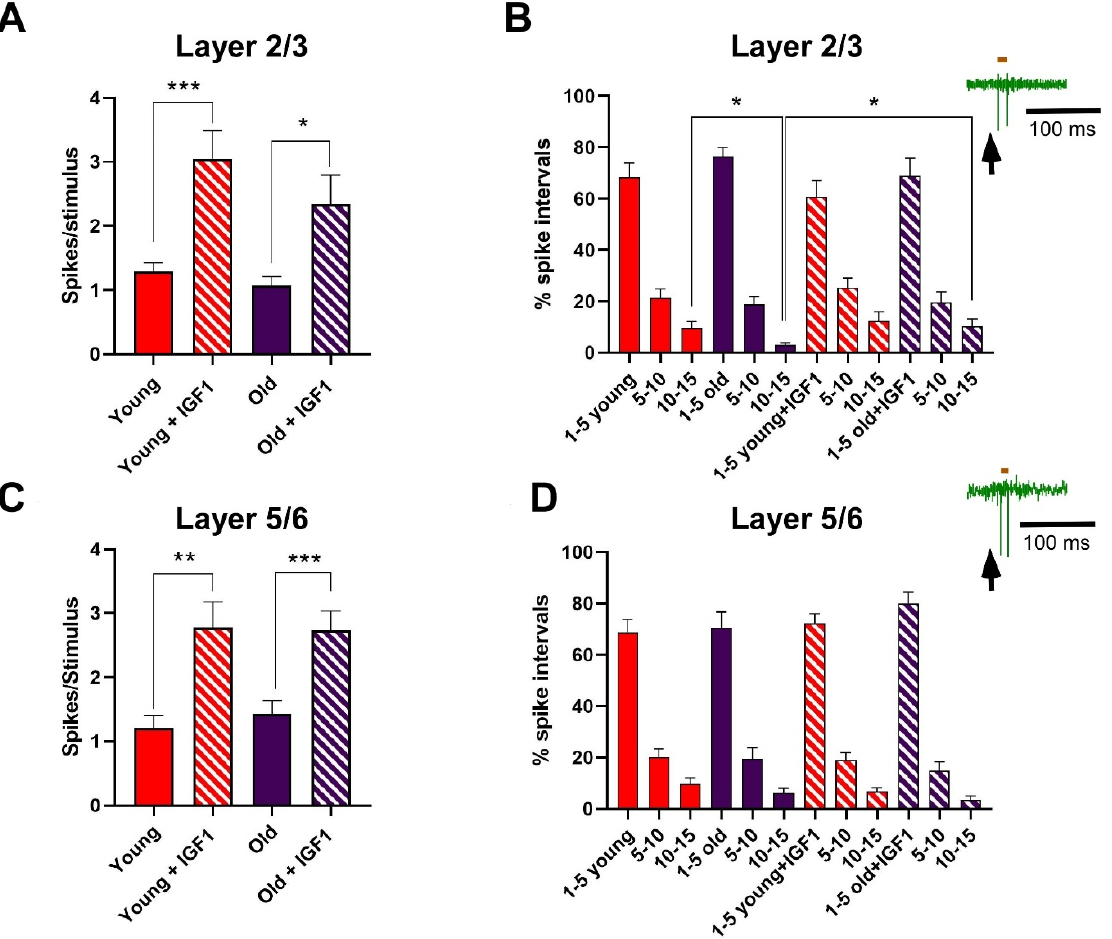
Figure 1. Responses to whisker stimulation increased in the presence of IGF-I in young and old animals in S1 cortex. ( A ) Plot shows the mean number of spikes/stimulus in layer 2/3 neurons in young animals (red) and old (purple) animals in comparison with values obtained 15 min after the application of IGF-I (10 nM; 0.2 μ L). Whisker responses were similar in young and old animals; responses increased after IGF-I application in both animal groups. ( B ) The mean percentage of spike intervals in three time ranges (1–5; 5–10 and 10–15 ms) during whisker responses in young and old animals is shown in layer 2/3 neurons. The percentage of spike intervals is shown in control condi- tion and 15 min after application of IGF-I. Data show a significant reduction in the percentage of long intervals (10–15 ms) in neurons recorded from old animals with respect to young ones. The percentage of long intervals in old animals was recovered when whisker responses were recorded after IGF-I application. Inset in B shows a representative response to whisker stimulation in a layer 2/3 neuron; the brown bar on the recording shows a spike interval used to calculate the interval histogram. ( C , D ) The mean responses in layer 5/6 neurons as shown in A and B. Note that whisker responses were similar in young and old animals in control conditions and increased after IGF-I application. The percentage of spike intervals did not show significant differences neither between different animal groups nor after the application of IGF-I. All values are expressed as mean ± SEM; Student’s t -test; * p < 0.05; ** p < 0.01, and *** p < 0.001 for comparisons. It is known that IGF-I increases neuronal response and its neuronal response is re- duced in aging (see Introduction). Thus, we studied its effect on whisker responses in young and old mice. In agreement with previous findings, local application of IGF-I in the S1 cortex (10 nM; 0.2 μ L) increased whisker responses 128% in layer 2/3 neurons of young animals (3.1 ± .0.4 spikes/stimulus, 15 min after IGF-I cortical application; n = 13; p = 0.002 with respect to basal values) and 89% in layer 2/3 neurons of old animals (2.3 ± 0.4 spikes/stimulus, 15 min after IGF-I cortical application; n = 11; p = 0.018 with respect to basal values; Figure 1A). Equally, IGF-I increased 74% the response of layer 5/6 neurons